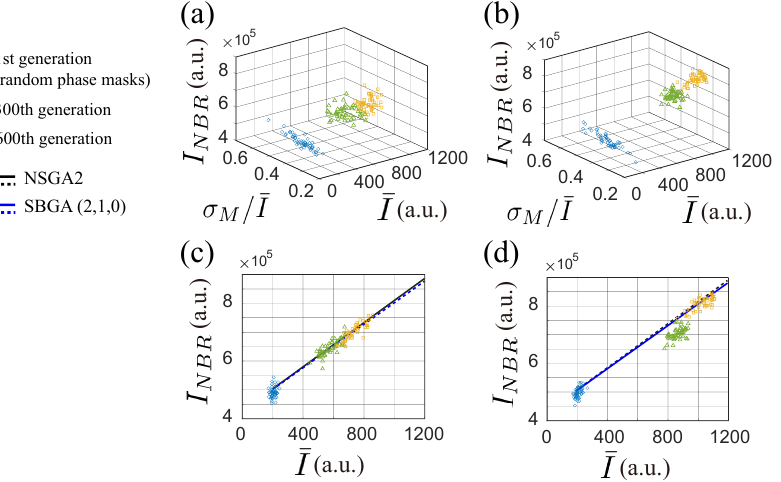
Figure 11. Experimental population evolution for NSGA2 (first column) and SBGA (second column). 3-D plots of population evolution with 2 discriminants ( f 1 , f 2 ) for ( a ) NSGA2, and for ( b ) SBGA with ranking coefficients ( a , b , c ) = ( 2,1,0 ) . 2-D plots shown in ( c , d ) present the relation between average intensity ¯ I and neighboring intensity I NBR . In each 2-D plot, the solid line follows the average evolution trend and the dashed line represents a comparison between NSGA2 (black) and SBGA